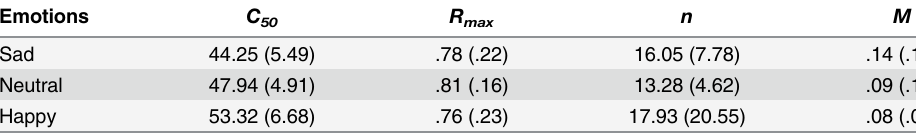
Table 3. Means and standard deviations of psychometric curve fit